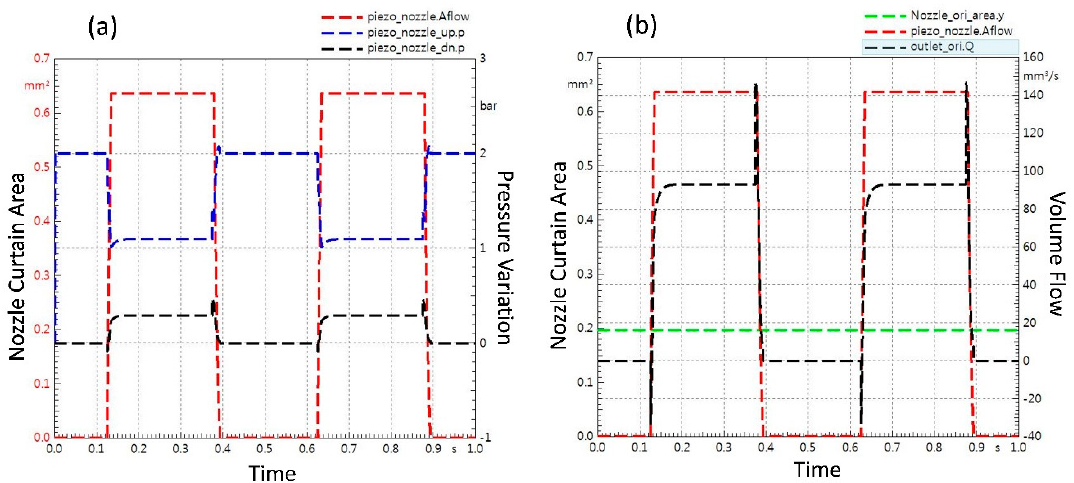
Figure 5. Nozzle opening area variation with tappet movement: ( a ) pressure variation in fluid chamber inside nozzle due to change in nozzle opening area; ( b ) influence of nozzle curtain area on fluid volume flow through nozzle.